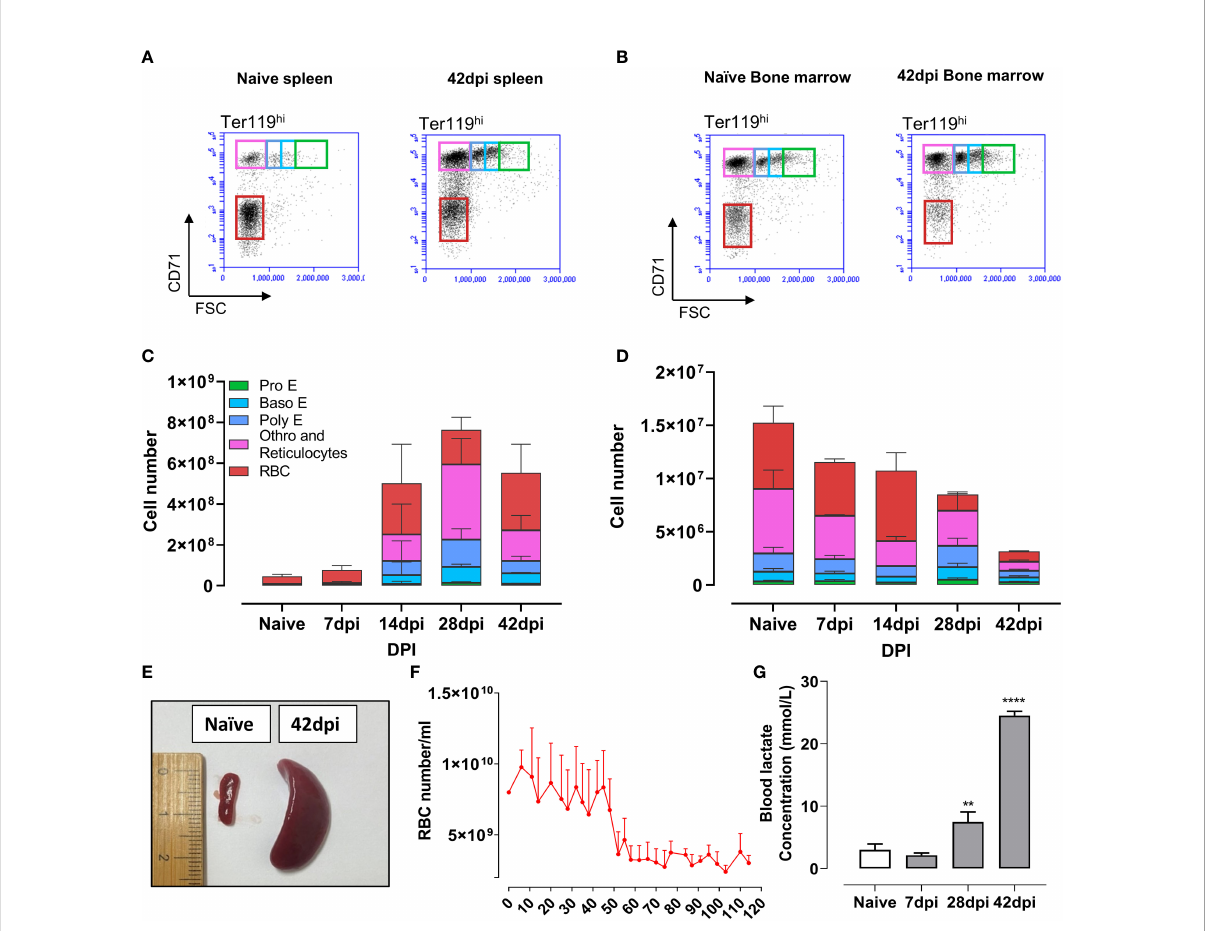
FIGURE 6 Truncated extramedullary erythropoiesis failed to compensate for the loss of erythrocytes lineages pool in bone marrow, resulting in anemia followed by lactic acidosis. (A, B) Erythrocyte lineage cells in spleen and bone marrow by fl ow cytometry analysis at naïve and 42dpi. Results